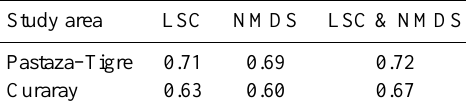
Table 2. Correlation coefficients ( r 2 ) for regressions of mean PV– NPV values against LSC, NMDS, and LSC & NMDS (all values significant at P < 0 .